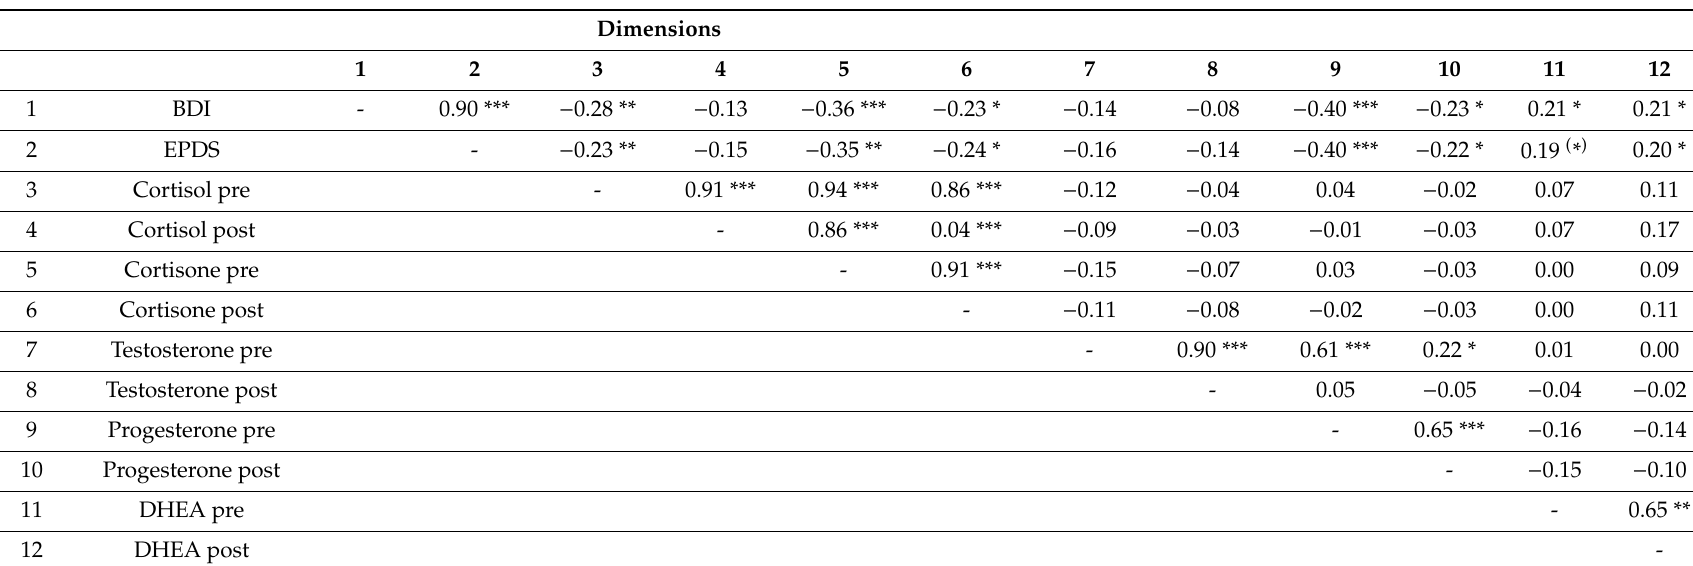
Table 3. Correlations between symptoms of depression and hair steroids ( N =